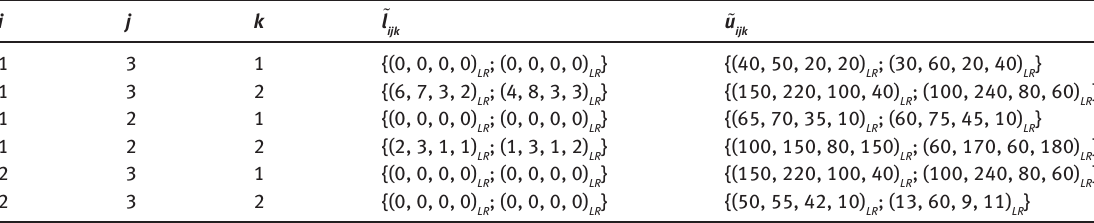
l (cid:31) and Maximum Intuitionistic Fuzzy Amount ( ijk